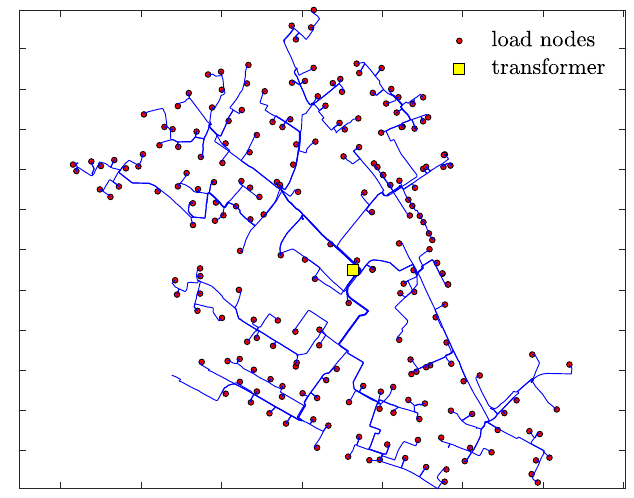
Figure 3. LV distribution grid